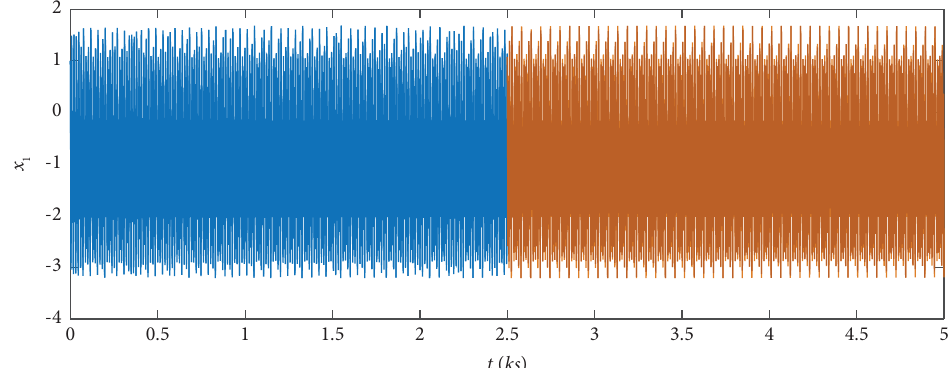
Figure 13: Time domain waveform of the system in time interval t ∈ ( 0 − 5000s ) .